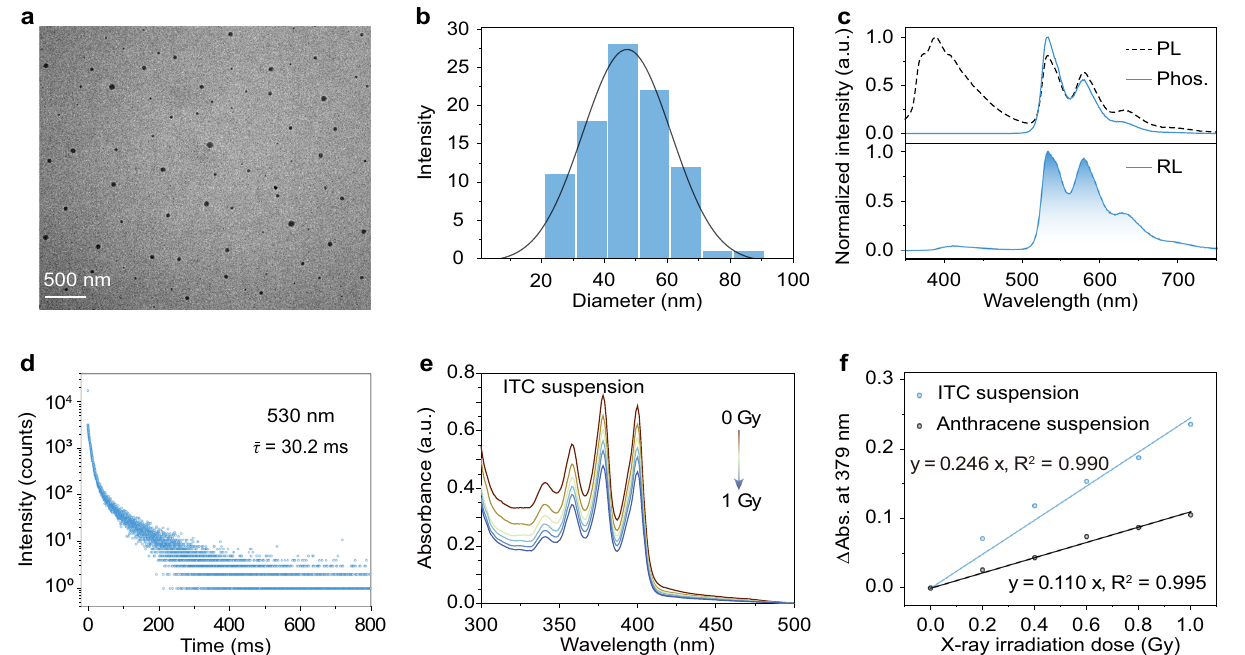
Fig. 2 | Characterization and photophysical properties of organic phosphor- escent nanoscintillators in aqueous solution. a TEM image of the prepared nanoparticles (scale bar: 500nm). b Size distribution of nanoparticles obtained by TEM. c Steady-state photoluminescence (PL, dashed line) and time-gated phos- phorescence(Phos.,solidline)spectraofthenanoparticlesinsolution,respectively (top). And the radioluminescence (RL) spectrum ofthe nanoparticles in solidstate